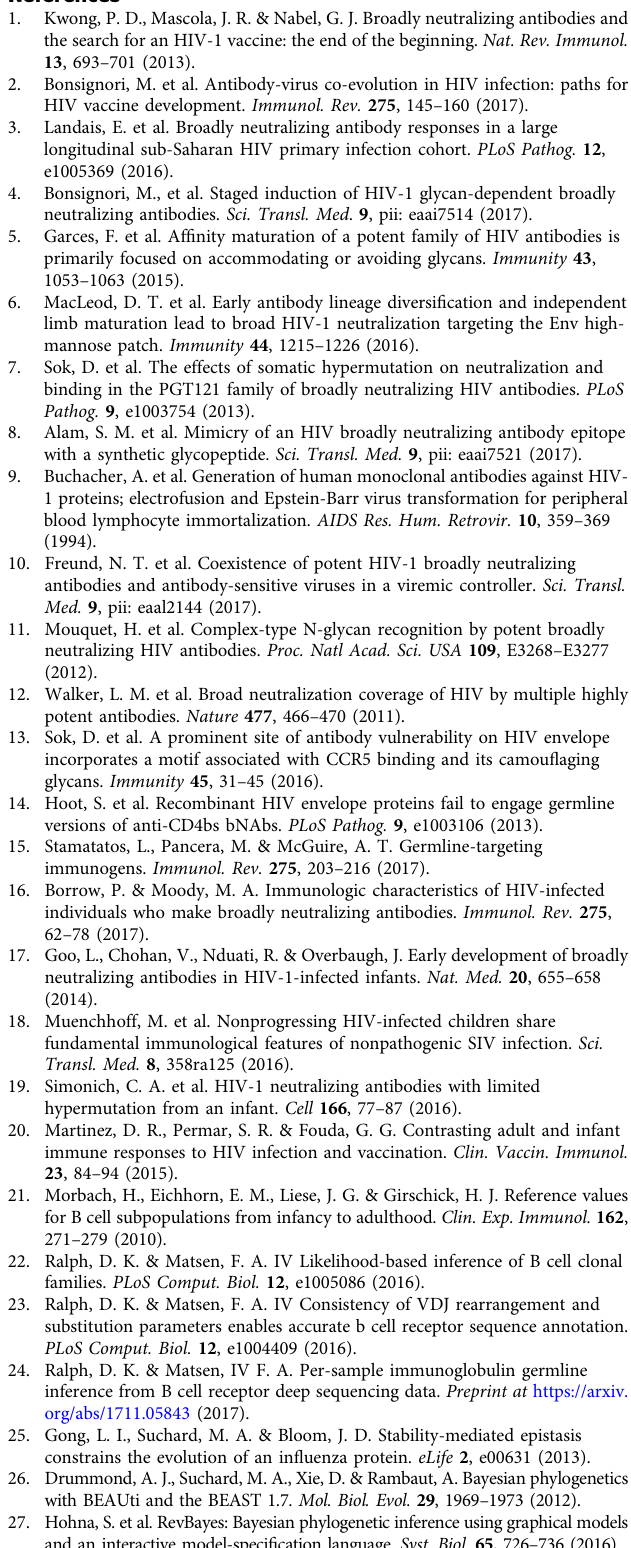
Fig. 5, PDB accession 6MN7 [https://www.rcsb.org/structure/6mn7]). Antibody variable region sequences for the inferred BF520.1 lineage intermediates, inferred naives, and minimal mutants are available in Supplementary Dataset 1.